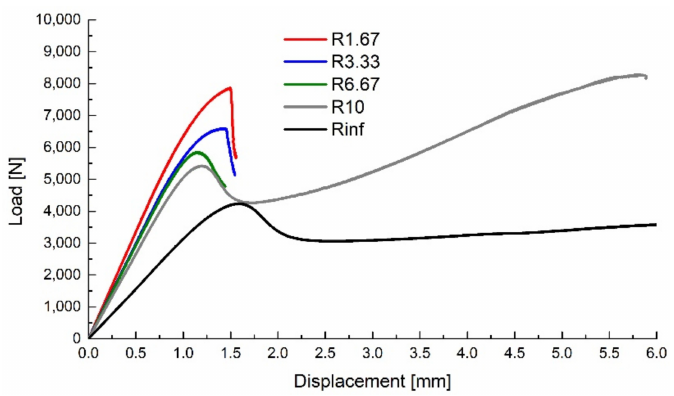
Figure 8. Upsetting test